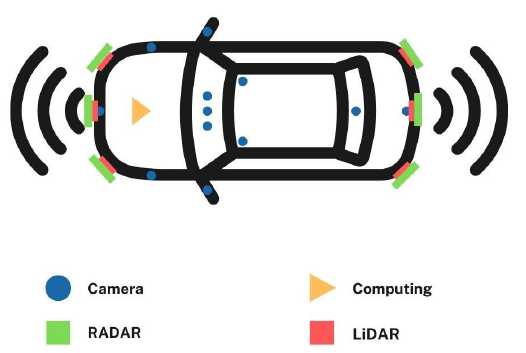
Figure 4. Types of sensors in